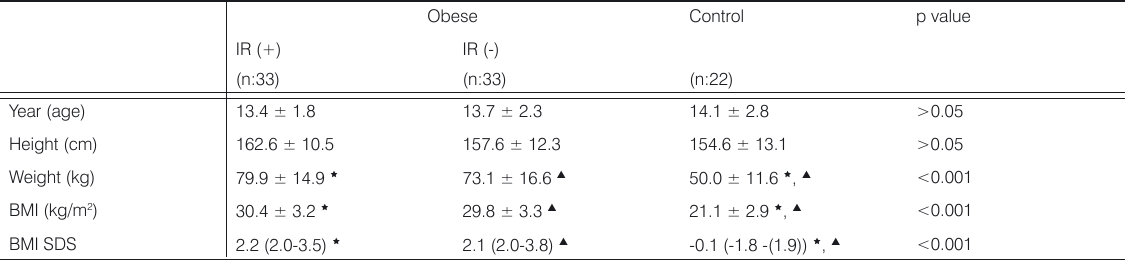
* Data are presented with the mean ± SD or median (min-max)  : p<0.05 : Between Group IR (+) and control  : p<0.05 : Between Group IR (-) and control